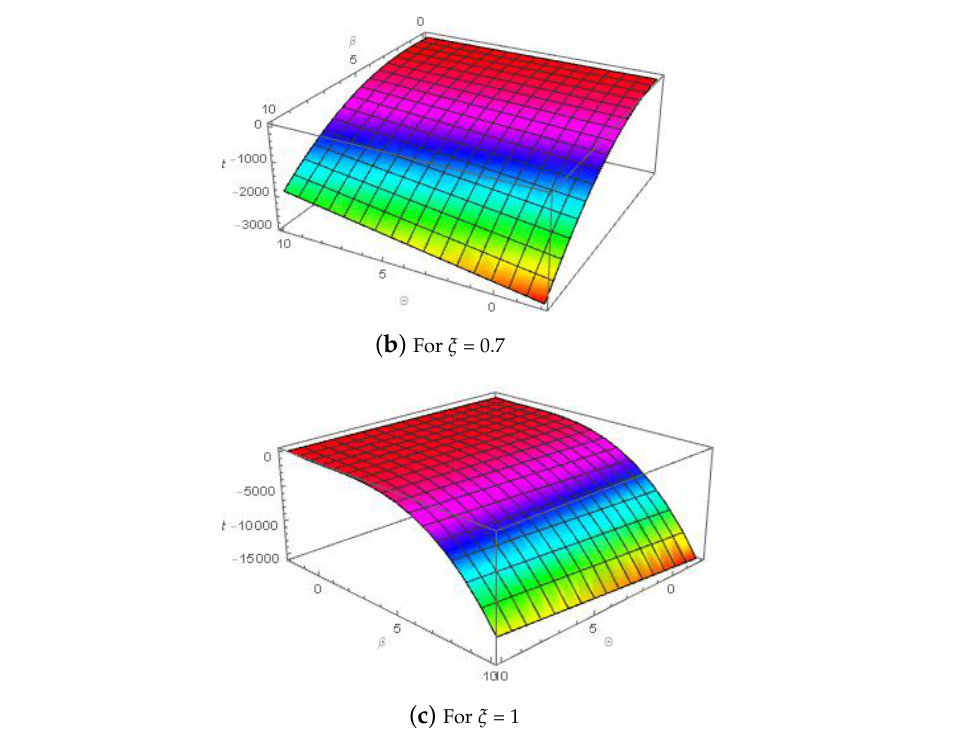
Figure 3. Representation of Θ for different values of ξ